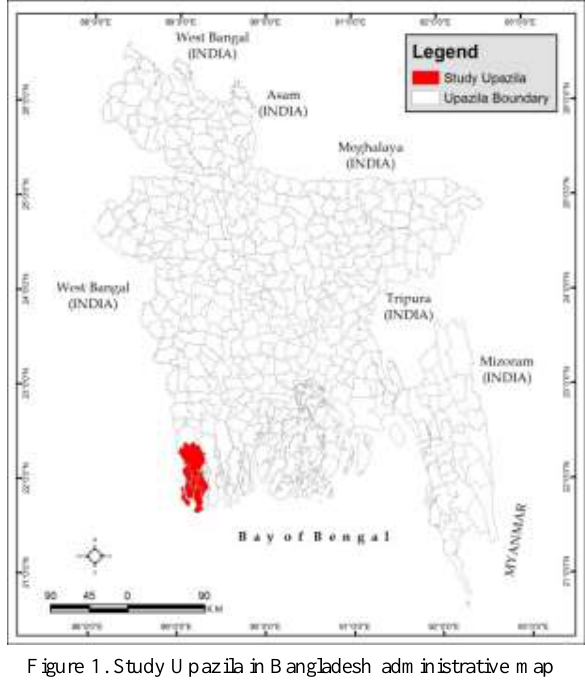
Figure 1. Study Upazila in Bangladesh administrative map